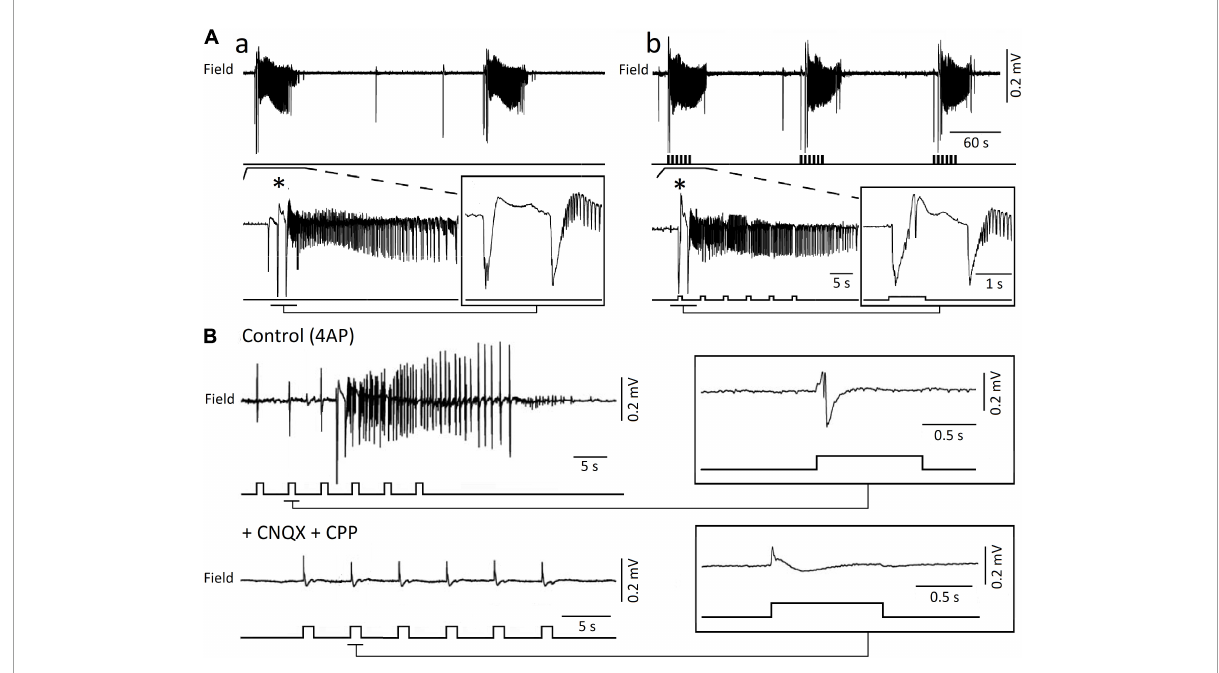
FIGURE4 (A) Ictal discharges recorded extracellularly from the mouse entorhinal cortex during application of 4AP can occur spontaneously (a) or be triggered by optogenetic activation of parvalbumin interneurons (b) . One ictal event for each experimental condition is further expanded to show the onset patterns that are in both cases characterized by 1 or 2 negative-going interictal-like spikes. (B) Blockade of ionotropic glutamatergic receptors (+ CNQX + CPP) abolishes ictal discharges induced by the optogenetic activation of parvalbumin-positive interneurons in the presence of 4AP; however, under these experimental conditions optogenetic stimuli continue to evoke slow interictal spike. (A,B) Are modified from Shiri et al. (2016). The onset of the ictal discharge ( ∗ ) is shown on an expanded time scale in the